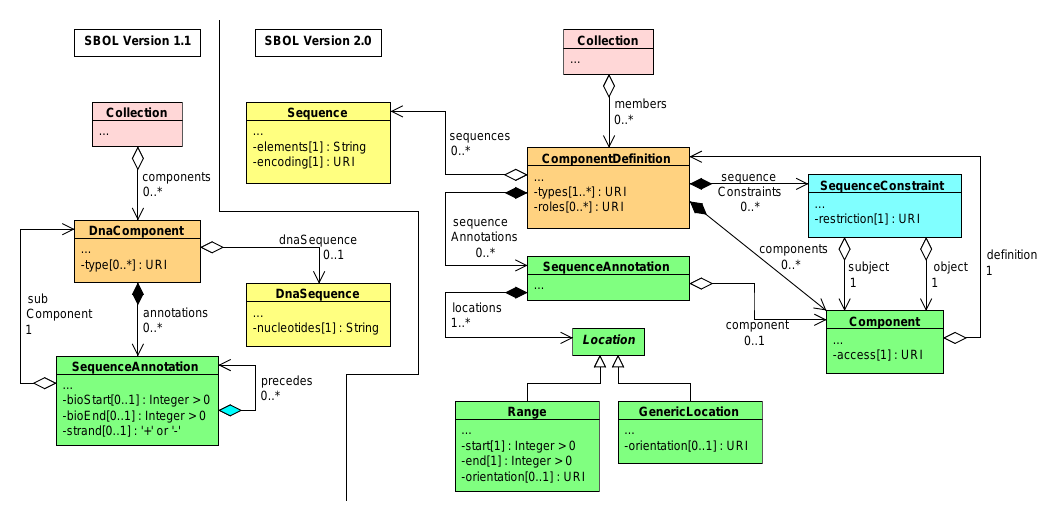
Figure 22: The mapping from the SBOL 1.1 data model to the SBOL 2.0 data model, indicating corresponding class- es/properties by color.